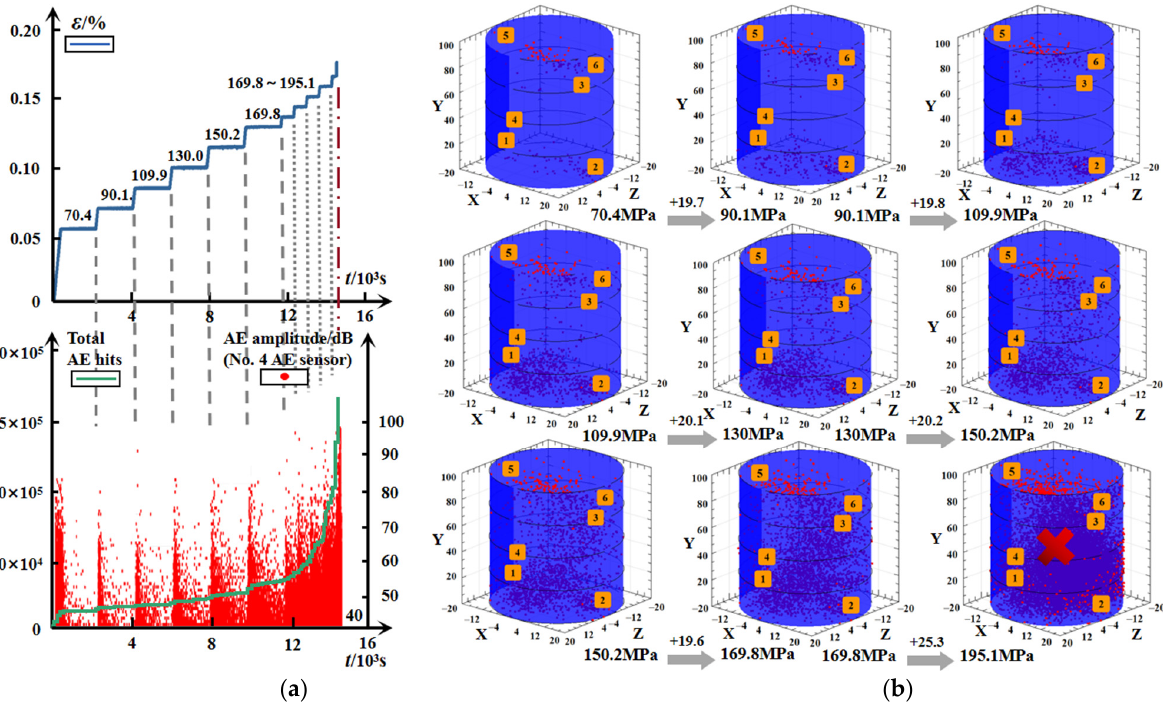
Figure 10. Time-dependent evolution of AE activities for granite. ( a ) AE hits and AE amplitude. ( b ) Spatial development of AE event points.